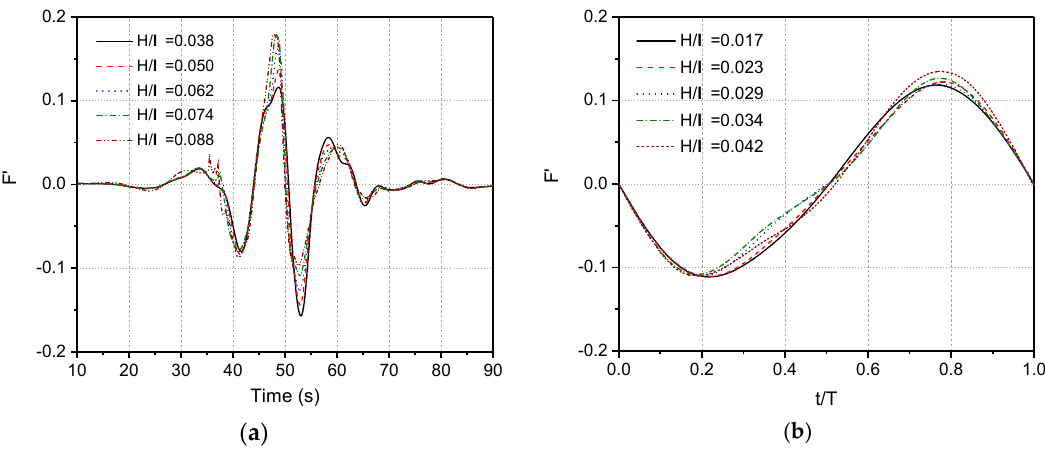
Figure 12. Dimensionless inline force under different wave steepness: ( a ) Focused wave (Cases 1 to Case 5 in Table 5) ( b ) Regular wave (Case 6 to Case 10 in Table 6).